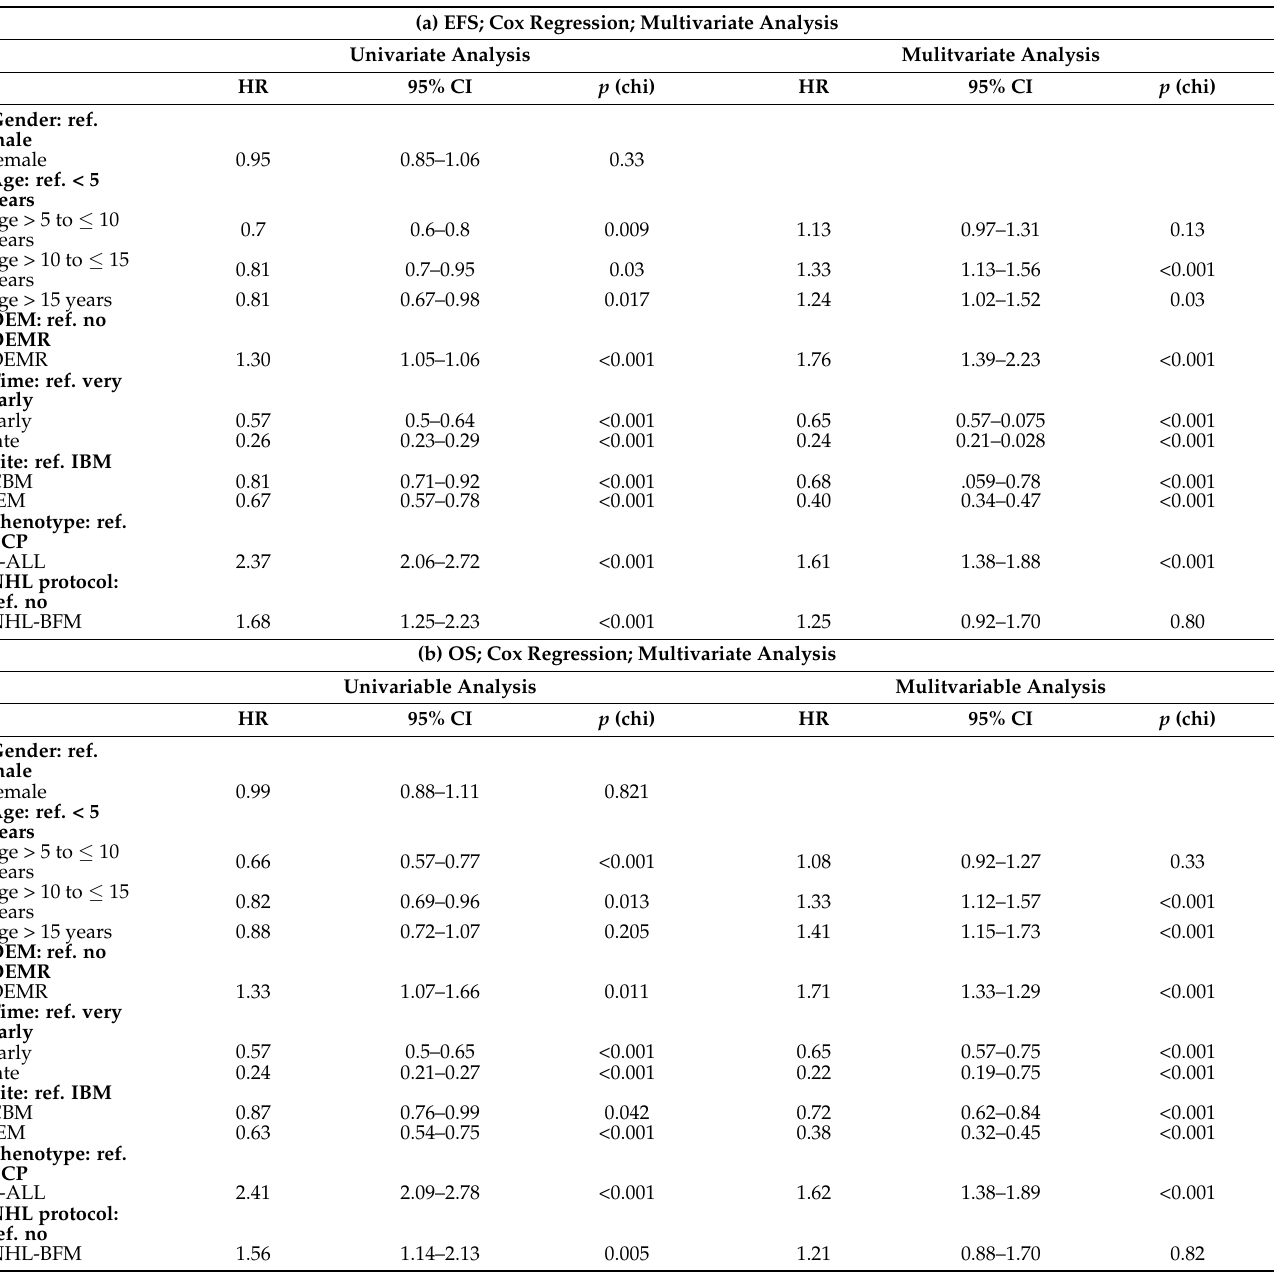
Legend to Table 6: Abbreviations: BCP, B-cell precursor; chi, chi-squared test; CBM, combined bone marrow relapse; CI, confidence interval; HR, hazard ratio; IEM, isolated bone marrow relapse; NHL-BFM, Non-Hodgkin’s Lymphoma Berlin–Frankfurt–Munster protocol; OEMR, other extramedullary